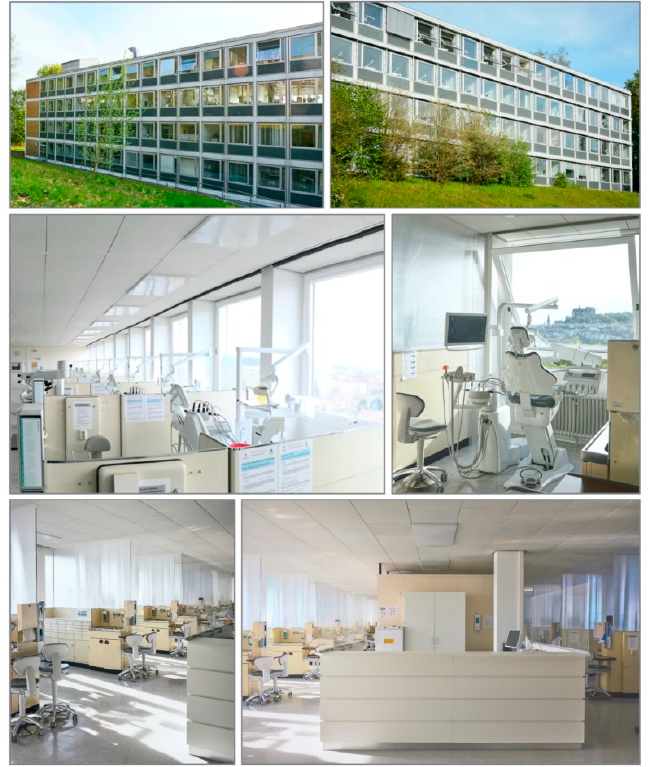
Figure 2. The dental clinic of Marburg (Building A) from the outside (rear/forest view left, City view right; OEP Department on the top floor). The arrangement of the course room of the OEP Department is shown in the middle row (left) with the course room before installation of the separations and new dental units in shown allowing a click-in mounting of the dummies in the dental chairs (2019), the right image in the middle row shows the new dental units with existing separations mandatory for the patient treatment in the students’ courses during the pandemic.